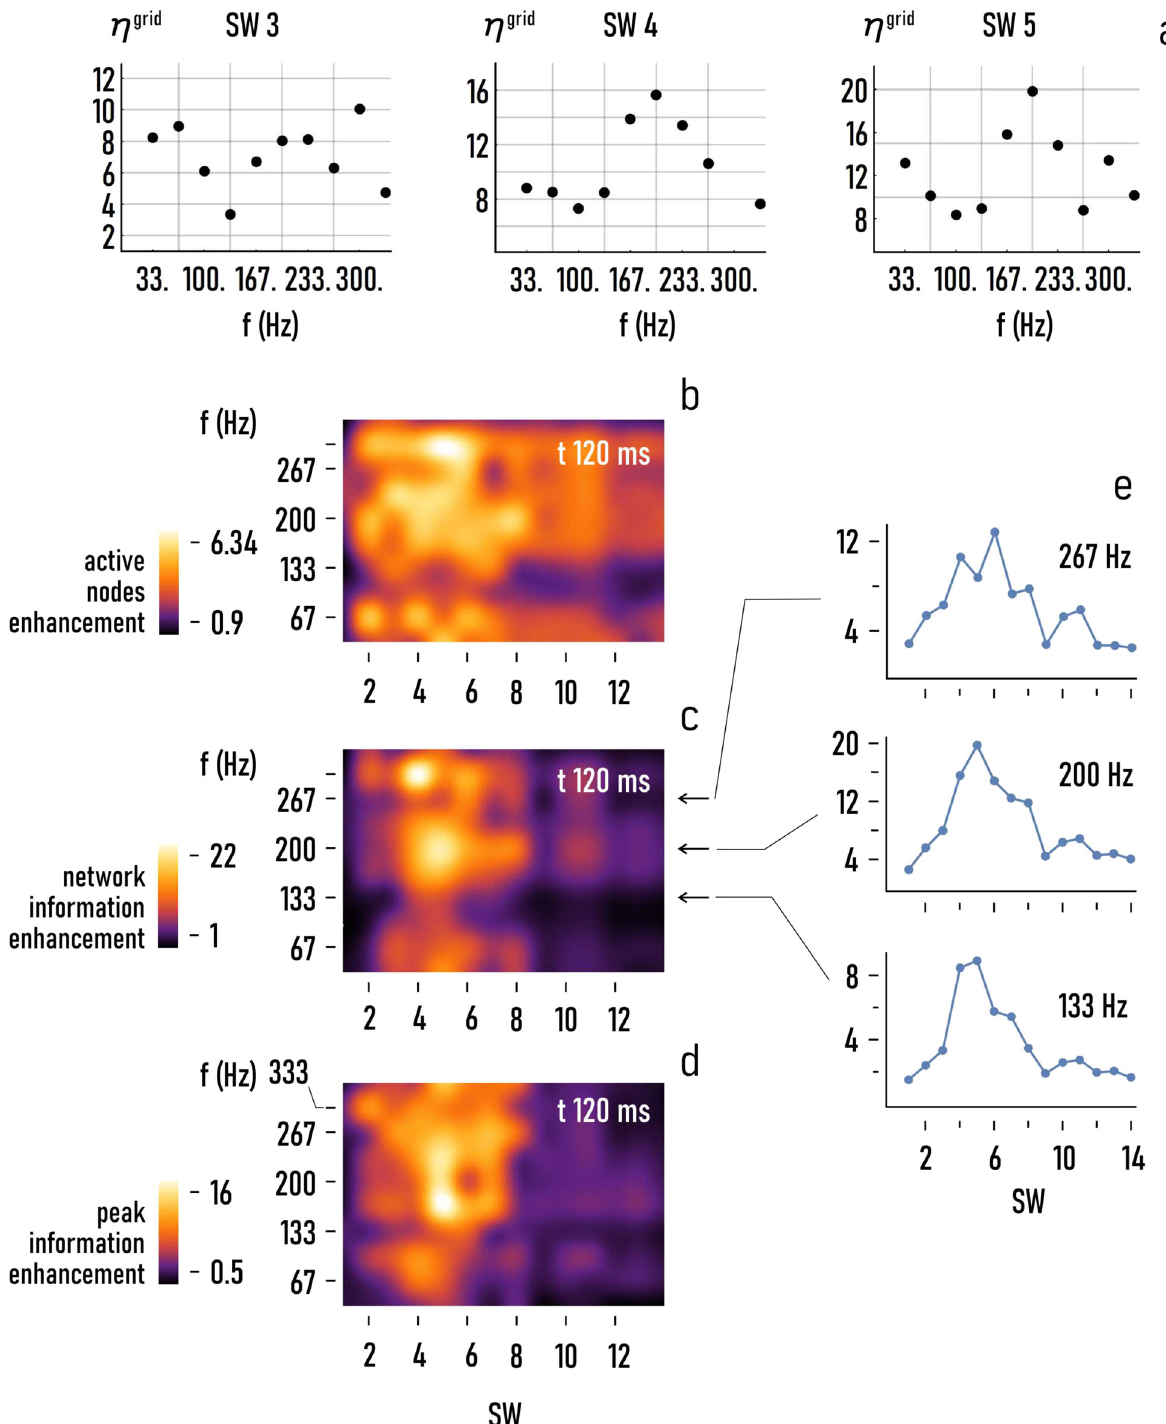
Fig. 4 Effect of signal frequency. As with Δ t , for constant values of SW the ef fi ciency of the grid η grid varies for varying values of the frequency of the originating input f ( a ). The density plots of η nodes ( b ), η grid ( c ), η peak ( d ) as a function of SW and f show the combined in fl uence of topology and frequency on the performance of the grid ( 4 t ¼ 120ms ). The diagrams of η grid against SW extracted from the density plot in c for the values of frequency f ¼ 133 , 200 , 267Hz , and 4 t ¼ 120ms ( e